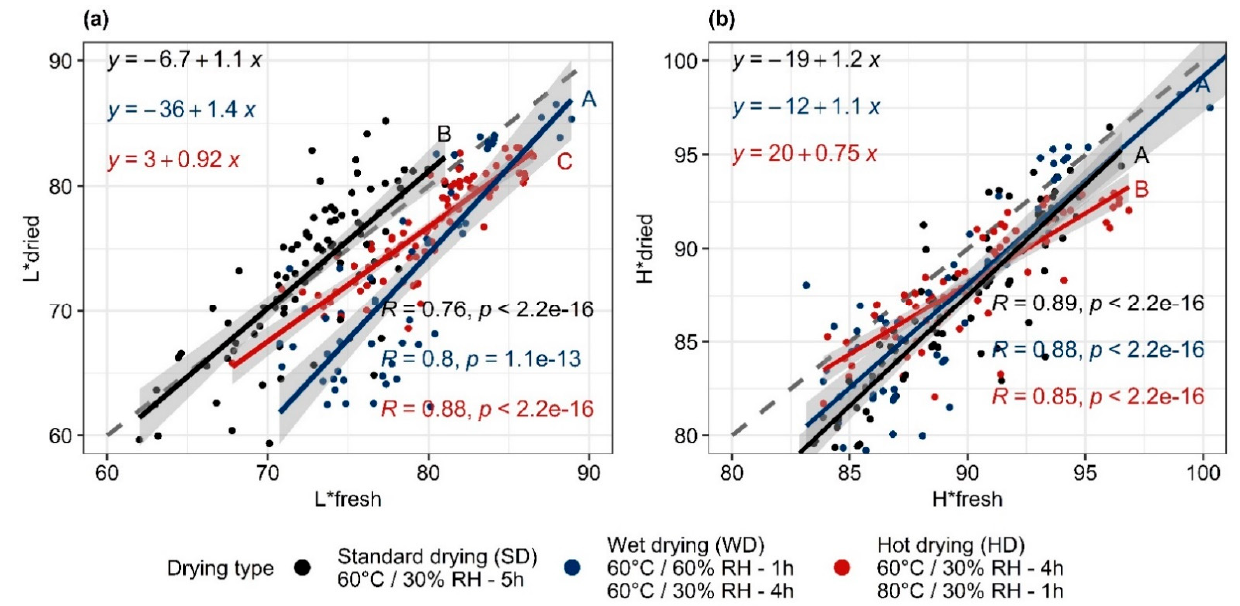
Figure 2. Linear regressions of color indices L* ( a ) and H* ( b ) measured on dried slices as a function of the same color indices measured on the same slices before drying, for each drying scheme. Grey dashed line: first bisector; dots: experimental data; solid lines with grey envelopes: regression lines with 95% confidence intervals. Different letters indicate significantly different regression lines at 5% threshold.